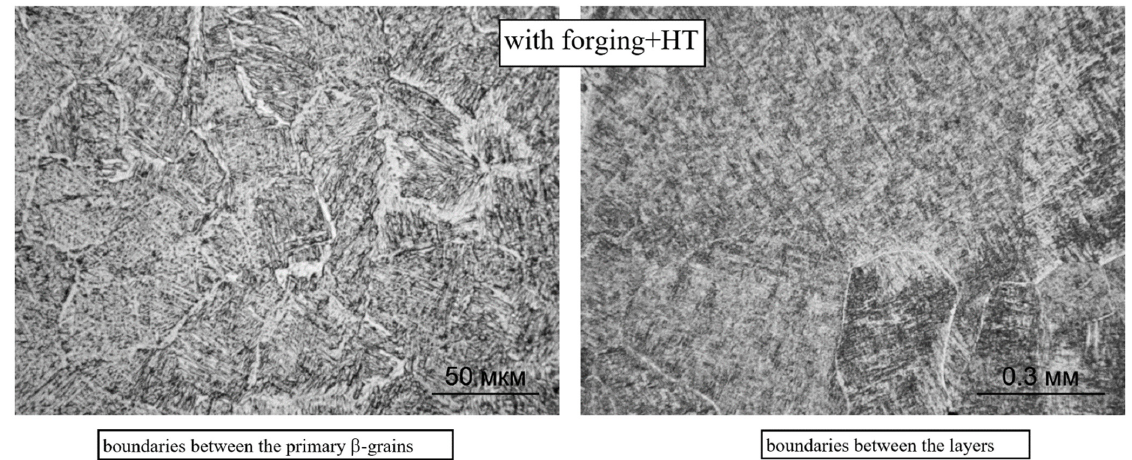
Figure 14. Microstructure and boundaries between primary β -grains (×500) and between layers (×100) during CMT depo- sition with forging after two-stage annealing (×500).